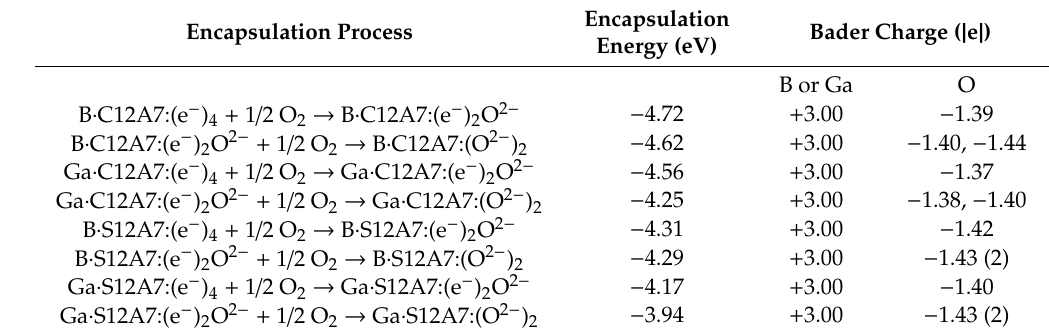
Table 6. The encapsulation energies and Bader charge on the encapsulated oxygen atoms in doped